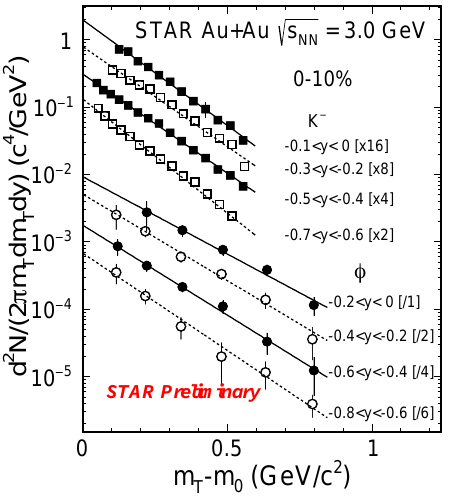
(cid:112) = 3 GeV in s NN